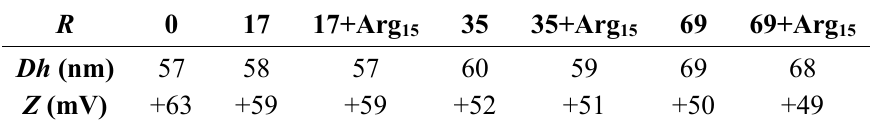
Table 2. Values of hydrodynamic diameter ( Dh ), and ζ -potential ( Z ) measured in water (pH 7) at a 3.10 − 3 M iron concentration after adding PolyR, Li28 at different ratios and then Arg 15